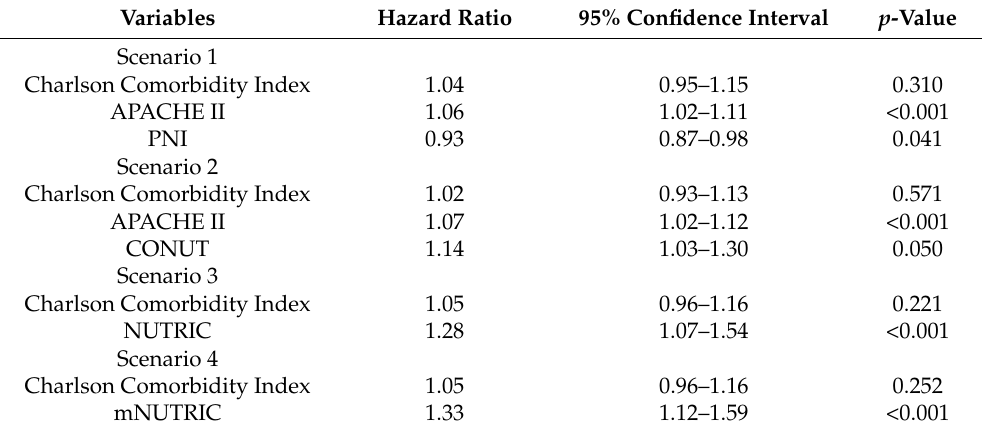
Table 4. Multivariate Cox proportional hazards analysis for the risk of in-hospital mortality. Variables Hazard Ratio 95% Confidence Interval p -Value